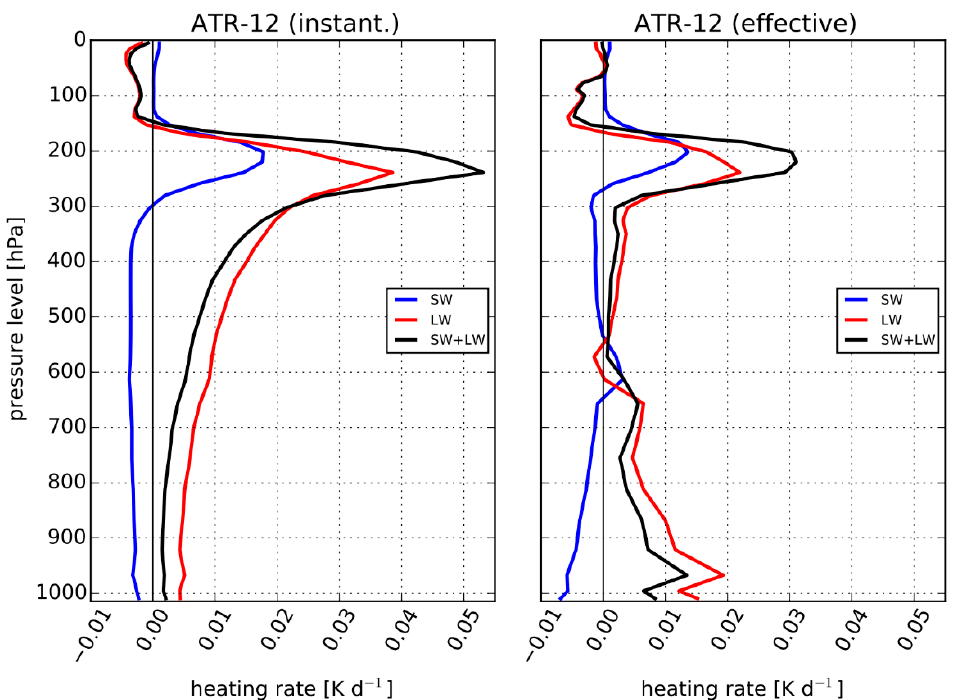
Figure 3. Global mean atmospheric heating rates (in K d − 1 ) induced by the contrail cirrus forcing in the ATR-12 simulation for the instantaneous forcing case (left) and for the effective forcing case (right). The latter case includes rapid atmospheric adjustments. Shortwave, longwave, and net RF are given in blue, red, and black color, respectively.